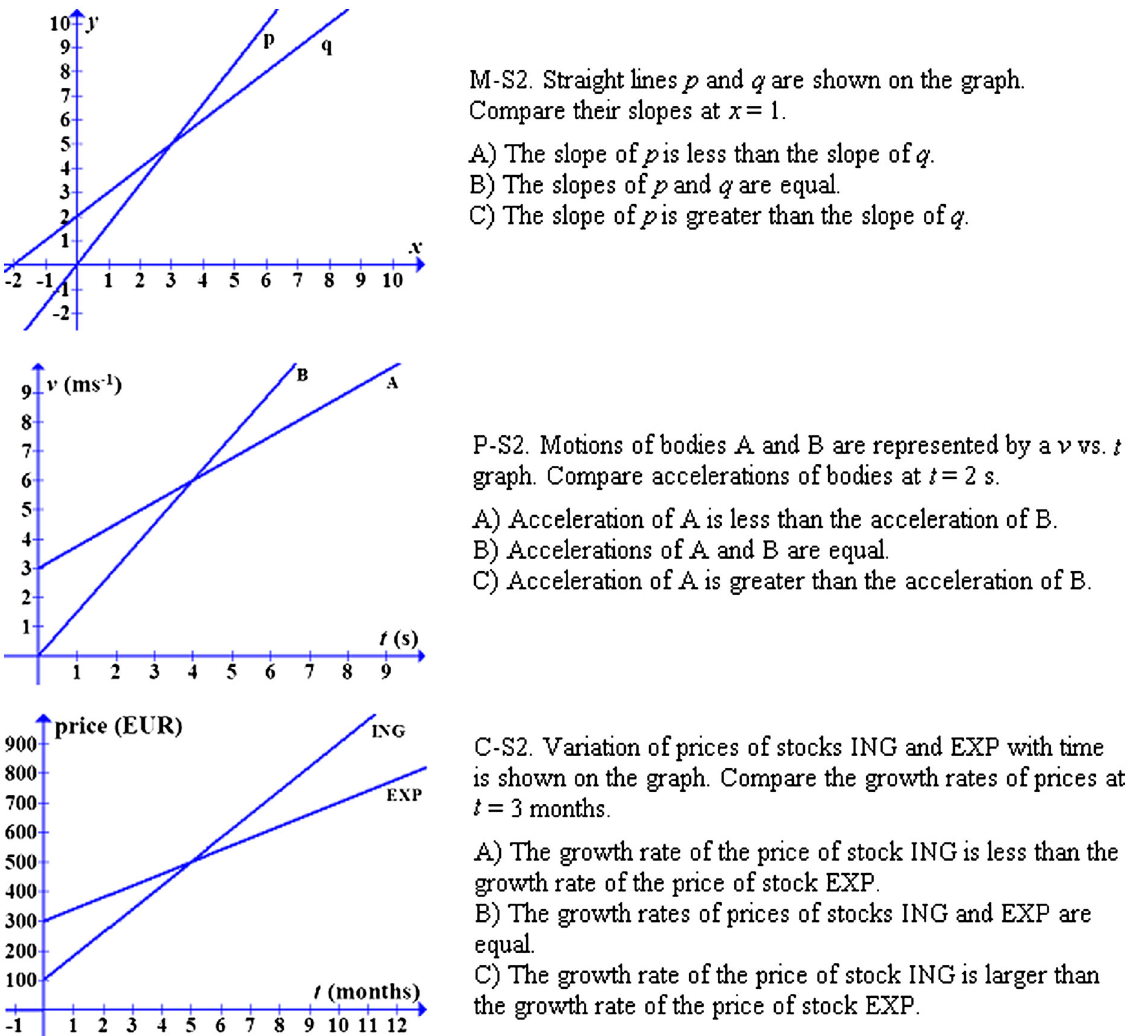
FIG. 1 (color online). Questions P - S 2 , M - S 2 , and C - S 2 : an example of a set of parallel slope items.